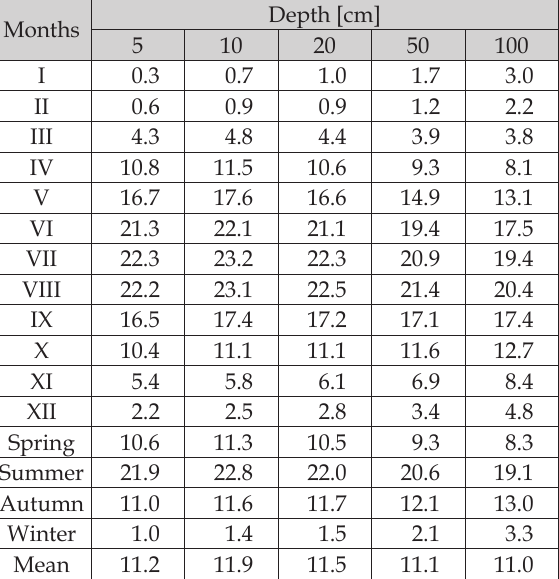
Table 2. Average monthly, seasonal and annual soil temperature [°C] at various depths in Poznań in